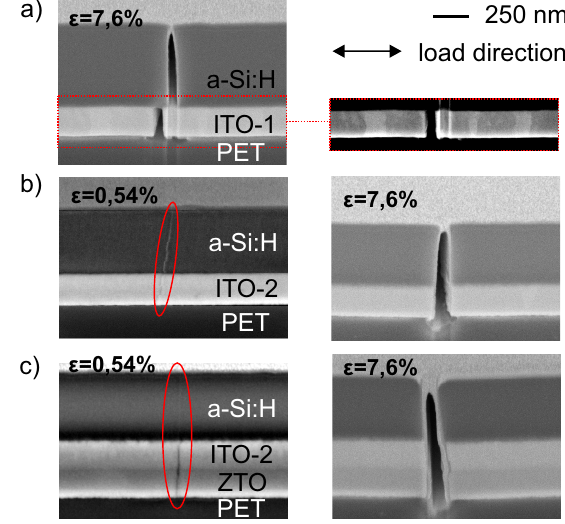
Figure 7. Cross-sections of bilayers of a-Si:H and ( a ) ITO-1 or ( b ) ITO-2 films on PET after tensile loading perpendicular to the crack path up to a maximum strain value as indicated in the images. The right image in (a) shows a detail of the layer stacks with enhanced contrast for a better visualization of grains; ( c ) A crack across a ZTO/ITO/a-Si:H trilayer after maximum applied strain as indicated in the